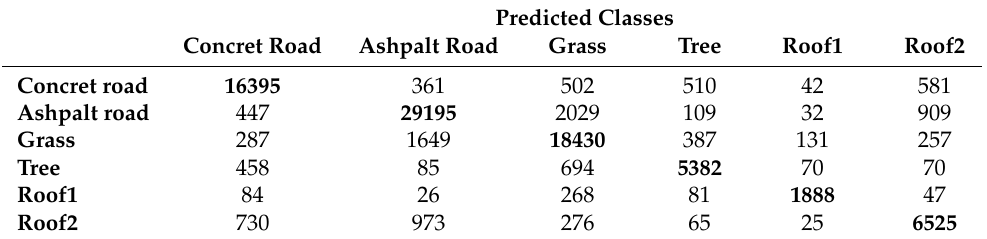
Table 8. Confusion matrix, related real classes with SMKSVD-TV results: HYDICE urban data.